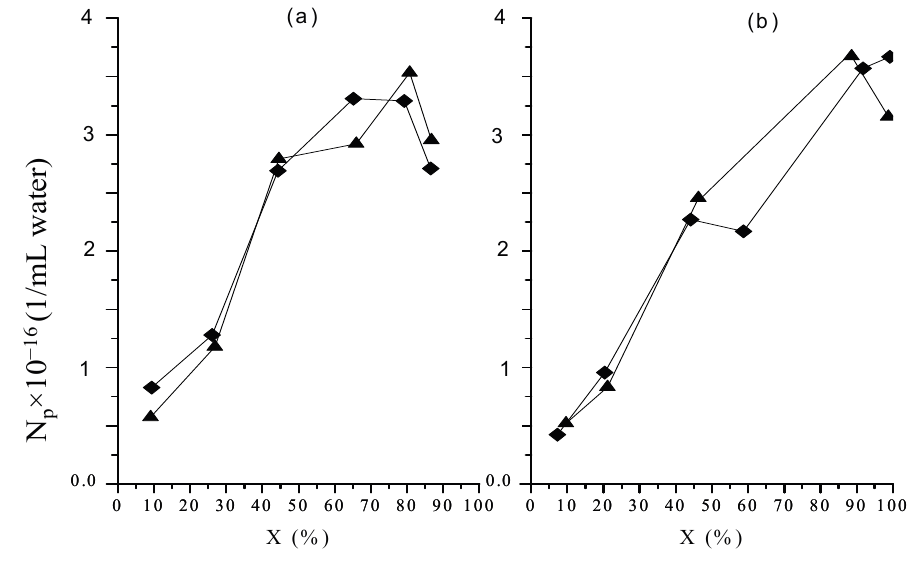
Figure 3. Particle number density as a function of global conversion in polymerizations at 0.05 ( a ) and 0.15 ( b ) g/min in organic dosing rate. Runs M ( ♦ ) ; runs MR ( ▲